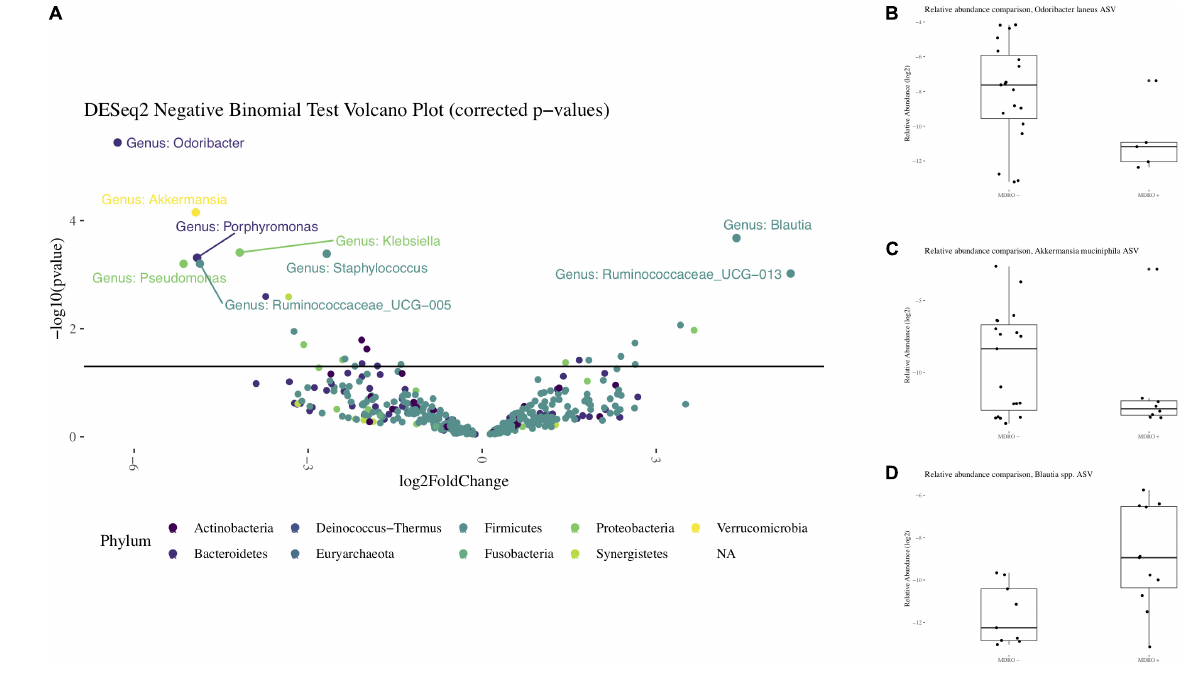
FIGURE 6 | Differential representation of taxa from the 16S rRNA amplicon sequencing. Panel (A) Volcano plot with differentially abundant features observed between subjects who acquired MDRO or not (MDRO+ or MDRO-, respectively). Only features whose relative abundances remained significantly different after correcting for multiple comparisons are labeled (FDR < 5%). A negative log2 Fold Difference in relative abundance indicates the feature predominated among MDRO-, and vice versa for MDRO+. Panels (B–D) . Boxplots with the relative abundances of Odoribacter laneus , Akkermansia muciniphila and Blautia spp. among MDRO- and MDRO+ subjects. MDRO, multidrug-resistant organisms; FDR, false discovery